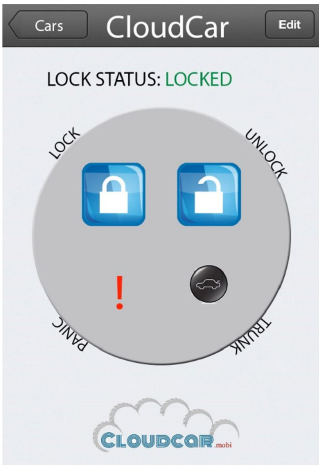
Fig. 8. Screenshot of the CloudThink remote actuation application, with live demo available here